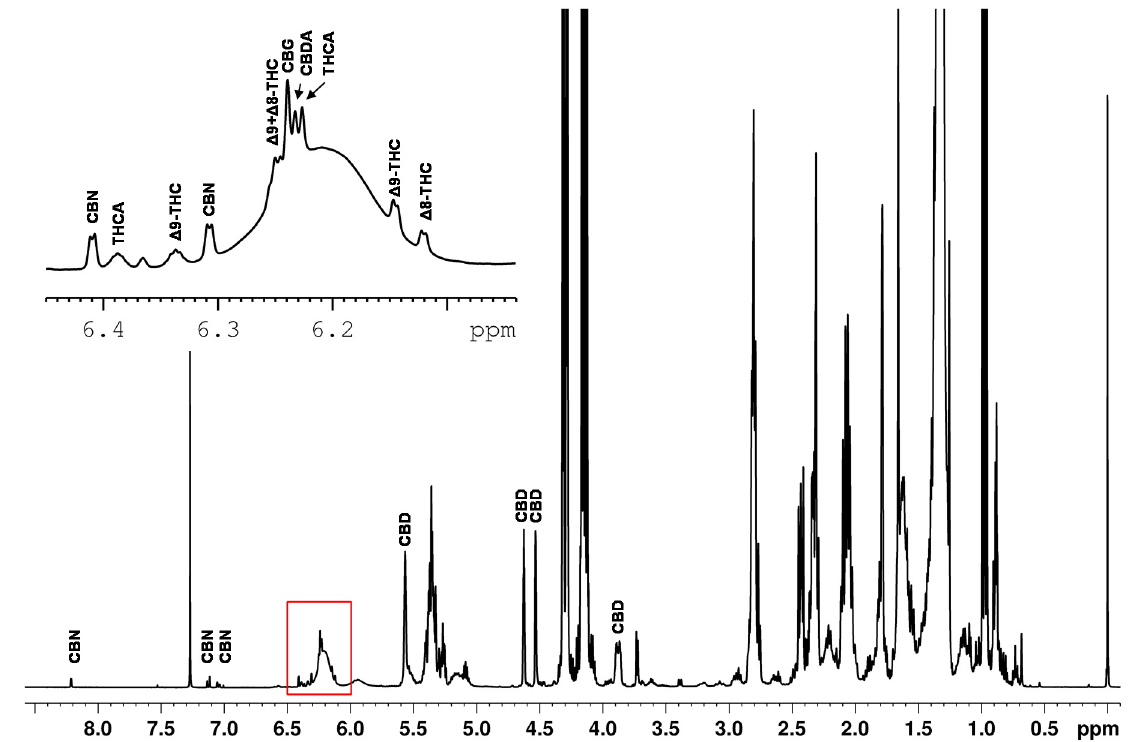
Figure 4. 1 H NMR spectrum of a hemp seed oil spiked with CBD, CBDA, ∆ 9 -THC, ∆ 8 -THC, THCA, CBG and CBN.